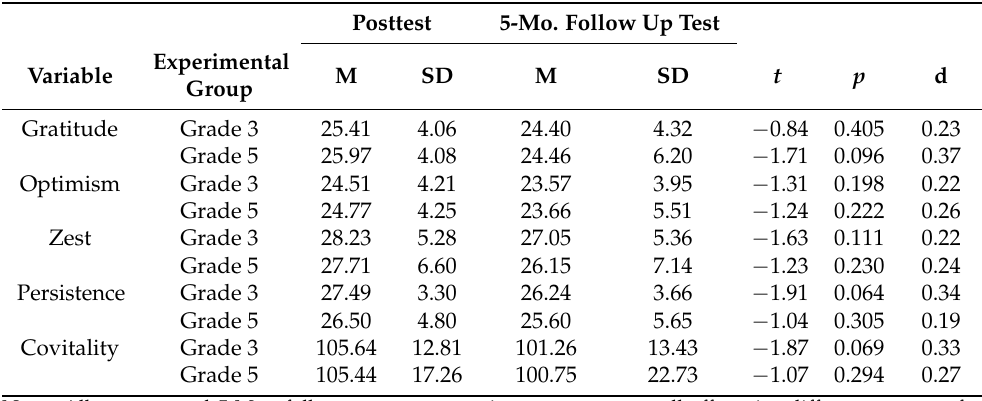
Table 3. Posttest and 5-Mo. Follow up test measures for experimental and control